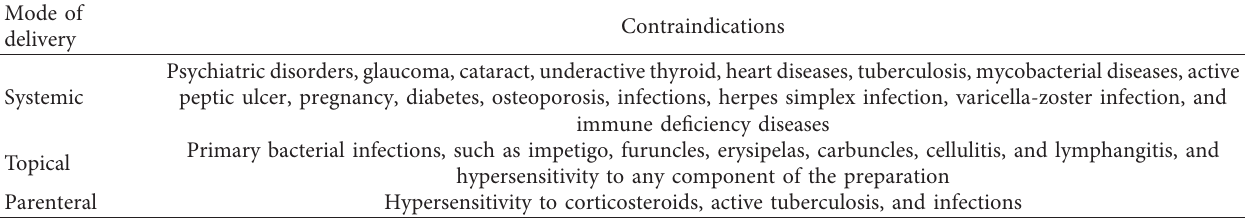
Table 1: Contraindications of cortisol use according to the route of administration [1].